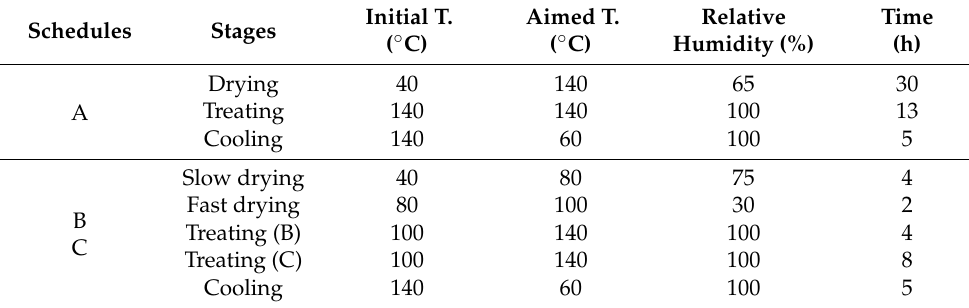
Table 1. Experimental process and parameters for schedule A, B and